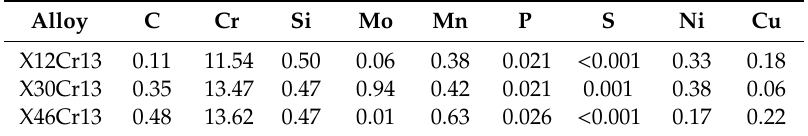
Table 1. Nominal composition of the investigated Martensitic Stainless Steels (MSS) alloys (wt % balance Fe).